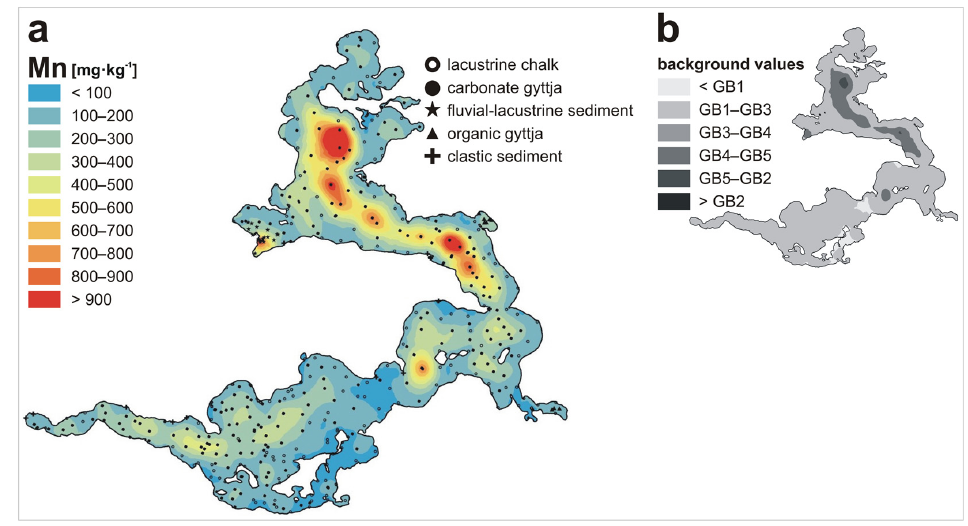
Figure 4. Manganese in recent bottom sediments of the Wigry Lake: ( a ) spatial distribution of Mn; ( b ) Mn mapped according to different geochemical background values implemented in the study (Table 3).